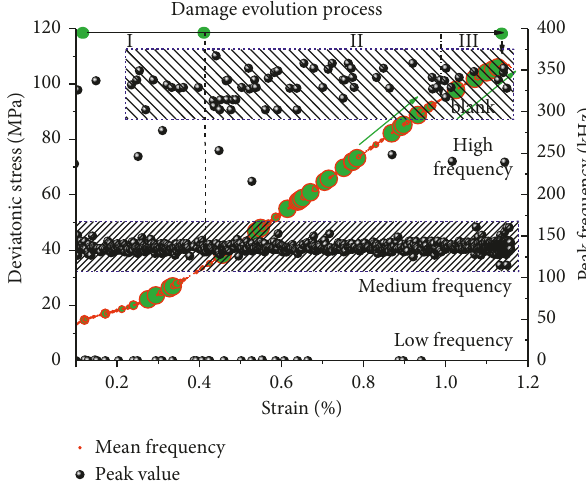
Figure 15: Damage evolution of peak frequency and average frequency by